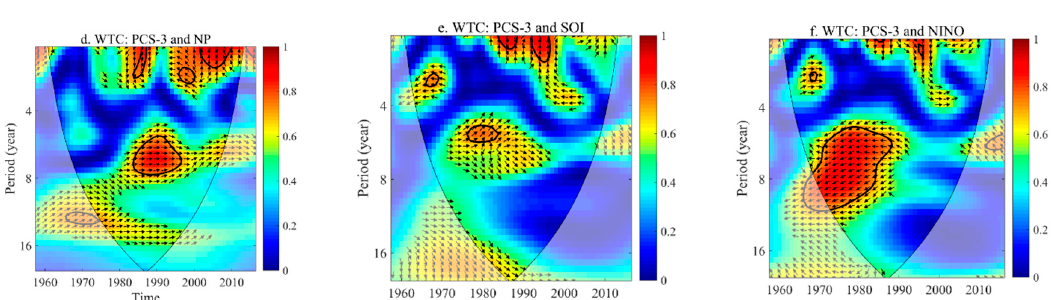
Figure 9. Wavelet coherence spectrum between PCS-3 and climate oscillations ( a – f climate oscillations of AO, NAO, PDO, NP, SOI and NINO,